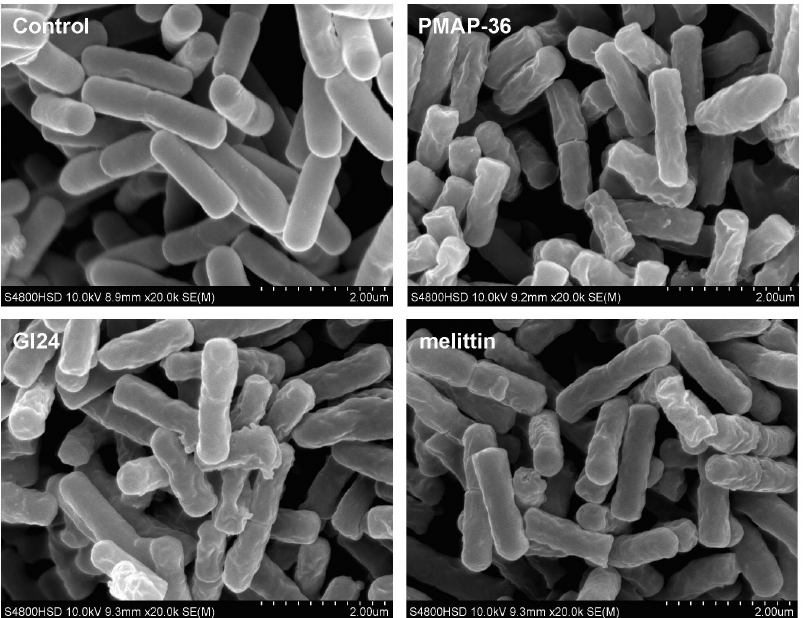
Figure 6. Scanning electron microscopic micrographs of E.coli treated with peptides. Bacteria were treated with peptides at MIC for 60 min. The control was done without peptides.